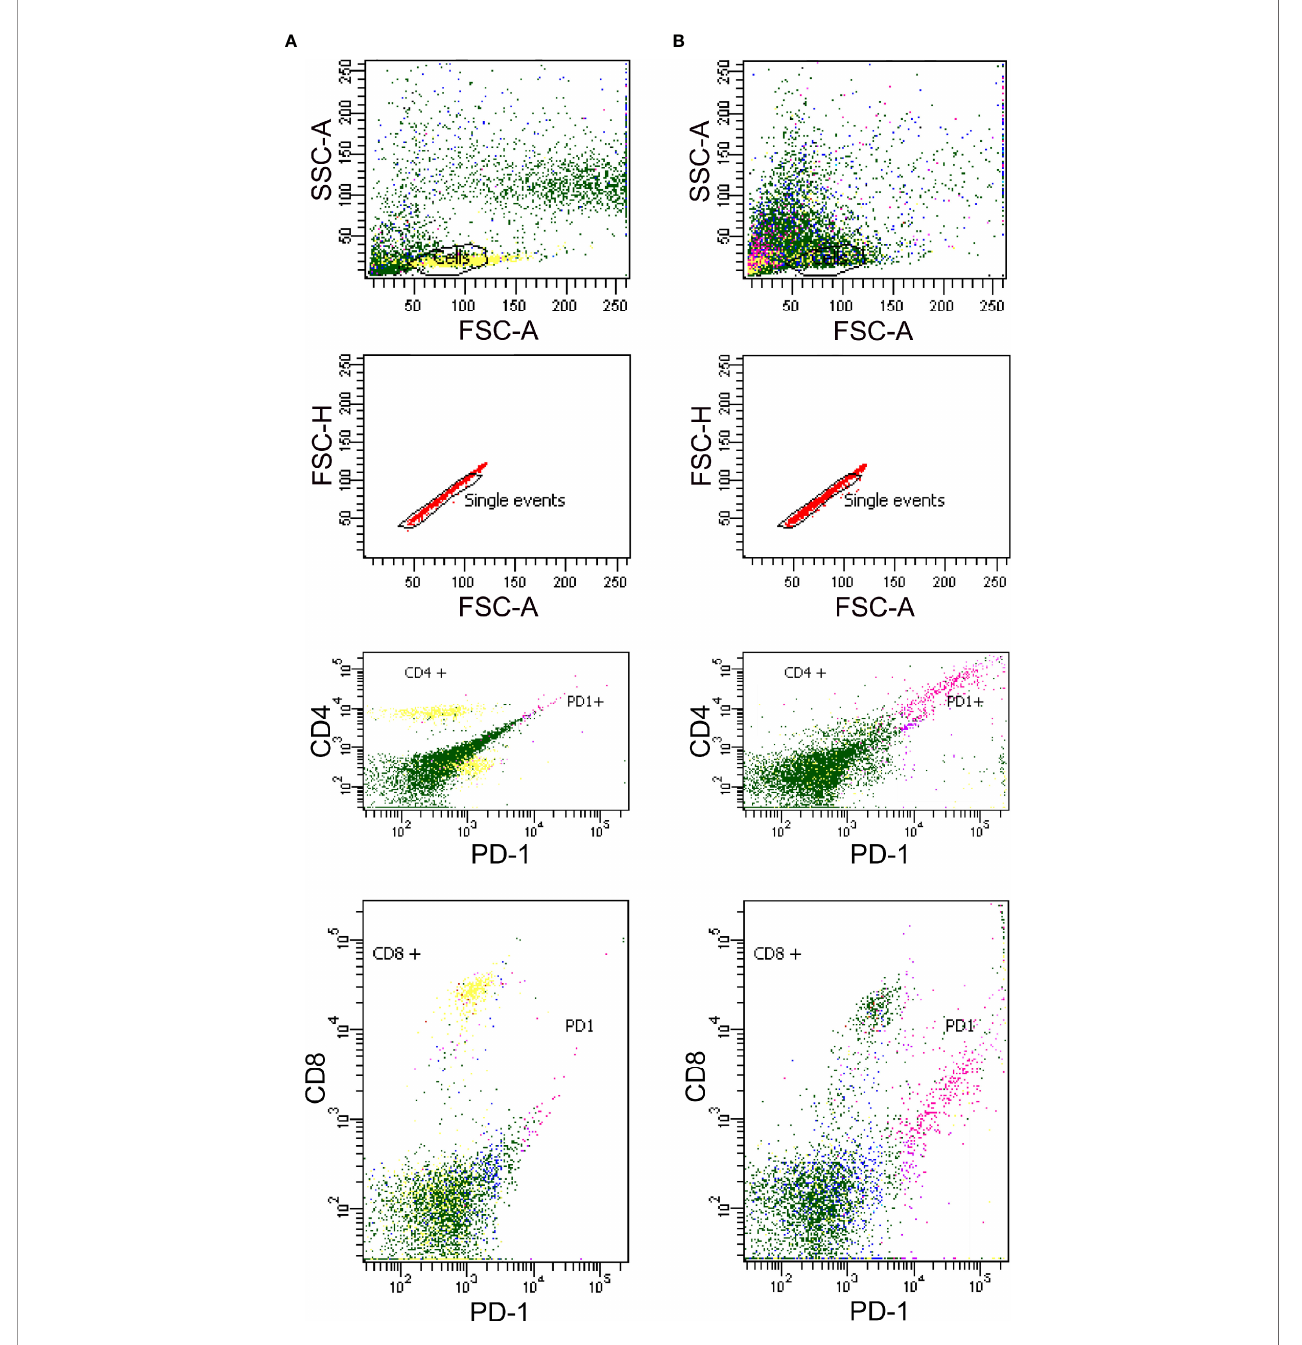
FIGURE 4 | Detection of PD1 in Human PBMCs from healthy controls by fl ow cytometry either unstimulated (A) and stimulated with PHA (B)